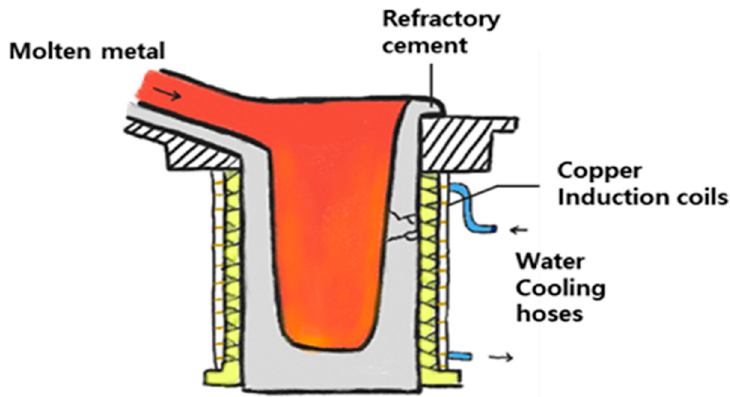
Figure 2. Schematic of induction furnace.